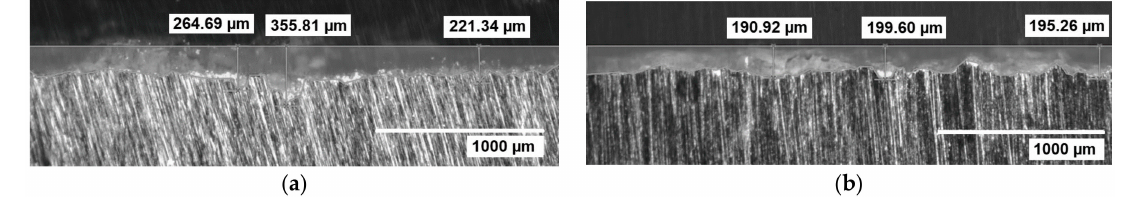
Figure 14. Cross-section macrograph of the samples after corrosion by polarization of Mg10Gd1Nd: ( a ) in extruded condition and ( b ) in